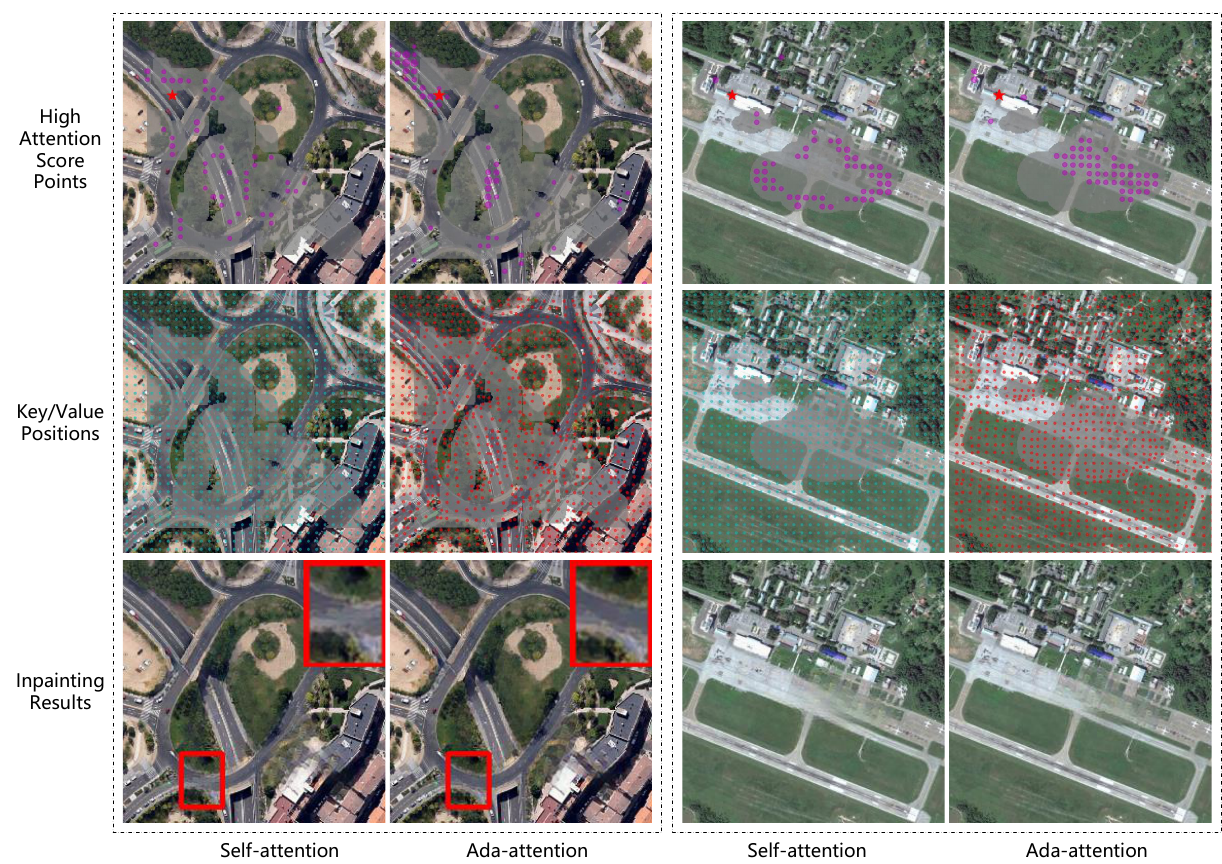
Figure 10. Illustration of self-attention and Ada-attention on AID dataset, including high-attention- score points, key/value positions, and inpainting results. The gray covering regions represent the corrupted regions. In the high-attention-score points images, the query is indicated by red stars, and the high-attention-score points of a specific query are represented by purple circles. A circle with a larger area represents a higher score. In the key/value positions images, the original uniform coordinates used in the self-attention mechanism are represented by cyan dots, while the sampled coordinates adjusted by the offset subnetwork in Ada-attention are represented by red dots. Local details are displayed in red boxes in the inpainting